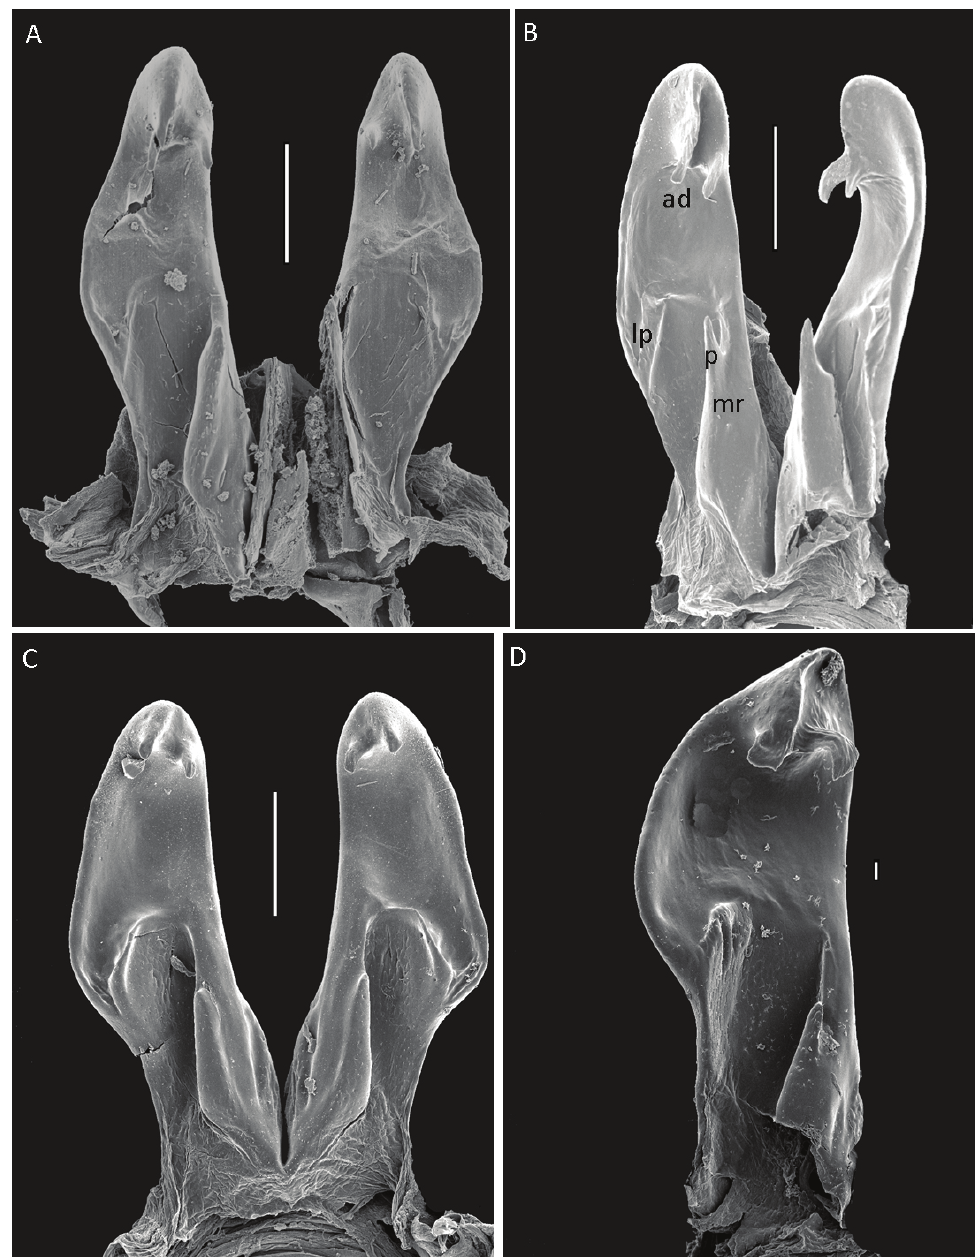
Fig. 3. Anterior gonopods, posterior views. A . D. typhlocanaria sp. nov., specimen from Barranco Draguillo. B . D. typhlocanaria sp. nov., specimen from Cueva de la Luna. C . D. oromii sp. nov. D. D. typhlops Ceuca, 1973, specimen from La Palma, right anterior gonopod. ad: apical denticles, lp: lateral prominence, mr: mesal ridge, p: projection. Scales 0.1 mm (A-C), 0.01 mm